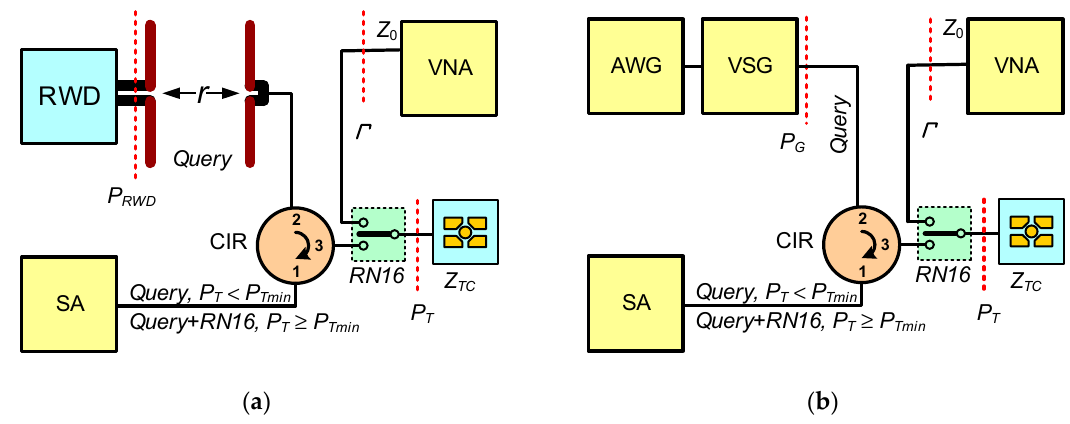
Figure 14. Methods of chip parameter determination: ( a ) Means by using RWD; ( b ) Means by using signal generator. SA—signal analyzer; VNA—vector network analyzer; AWG—arbitrary wave generator; VSG—vector signal generator;